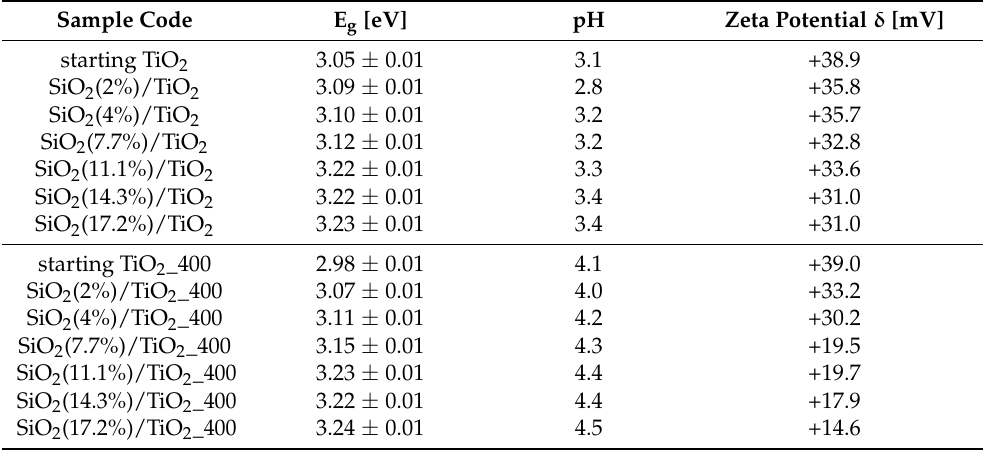
Table 2. The band gap energy and zeta potential values of starting TiO 2 and silica-modified titania